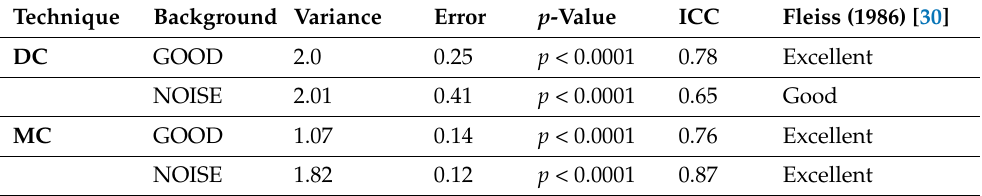
Table 3. Interobserver